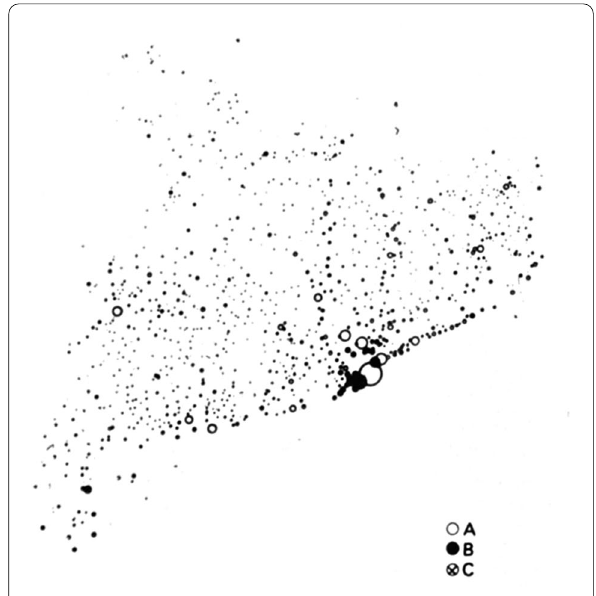
Fig. 6 Solà-Morales. ‘Capital i ciutats en Catalunya. Una perspectiva de futur’. System of Urban Settlements. 1979. Source: Solà-Morales M (1979 [1997]) Las Formas de Crecimiento